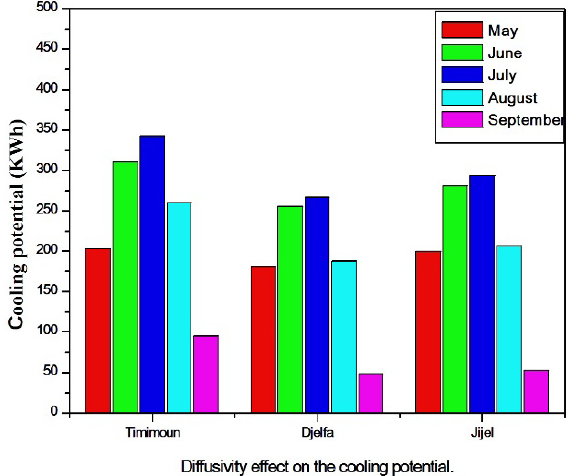
Figure 9. The monthly cooling energy provided by the EAHE for different thermal diffusivity.